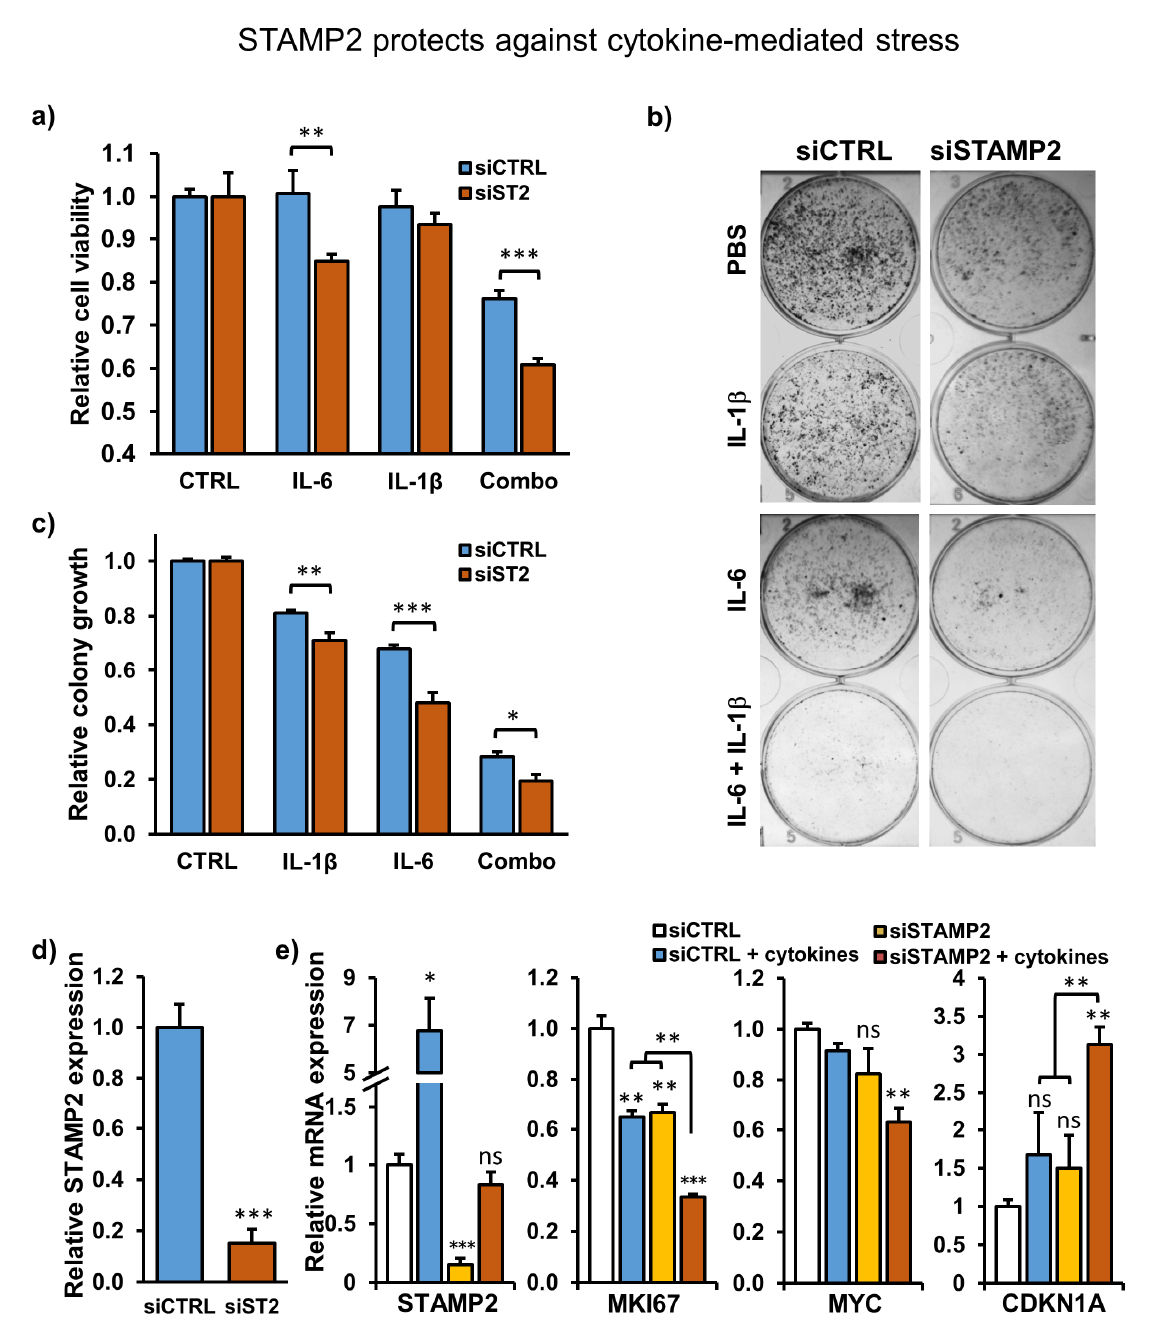
Figure 5. STAMP2 protects against cytokine-mediated stress. ( a – c ) C4-2B cells were reverse transfected with 5 nM STAMP2 or control siRNA in a six-well plate and 24 h later harvested and replated into 96-well plates (for cell viability assay) or six-well plates (for colony formation assay). Three hours later, the cells were induced with the indicated cytokines and the viability of the cells was determined 72 h later by the CCK-8 assay ( a ). Colony formation assays were developed nine days post-reseeding ( b ). The relative amount of viable cells in the growing colonies was determined by the CCK-8 assay ( c ) and the efficacy of STAMP2 knockdown was verified by qRT-PCR ( d ). ( e ) The effects of combined (IL-1 β and IL-6) treatment on STAMP2 knockdown and control C4-2B cells were determined by qRT-PCR 72 h after replating. Statistics shown by asterisks above the columns are relative to non-induced siCTRL transfected samples. * p < 0.05, ** p < 0.01, *** p < 0.001.